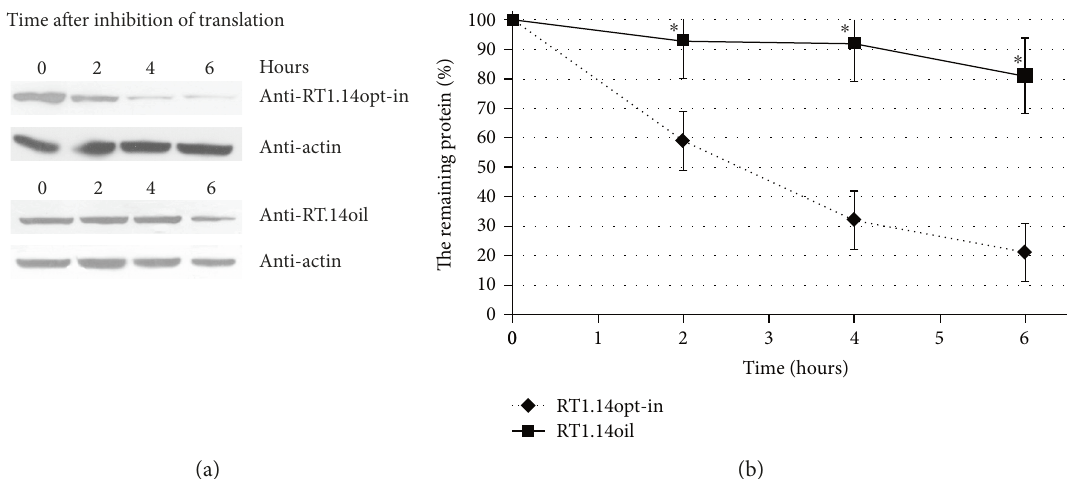
Figure 4: The kinetics of degradation of RT1.14opt-in and RT1.14oil in HeLa cells after blocking of translation with cycloheximide. (a) Western blotting of HeLa cells transfected with pVaxRT1.14opt-in and pVaxRT1.14oil plasmids 0, 2, 4, and 6 hours after cycloheximide treatment. The blots were stained with polyclonal anti-RT antibodies. To control equal loading of the samples on the gel, membranes were restained with anti- β -actin antibodies. (b) Diagram of protein degradation speed. 100% is according to initial amount of the protein. The graph is plotted in accordance with the results of 3 independent experiments, ± SD. ∗ p < 0 05 (Mann – Whitney